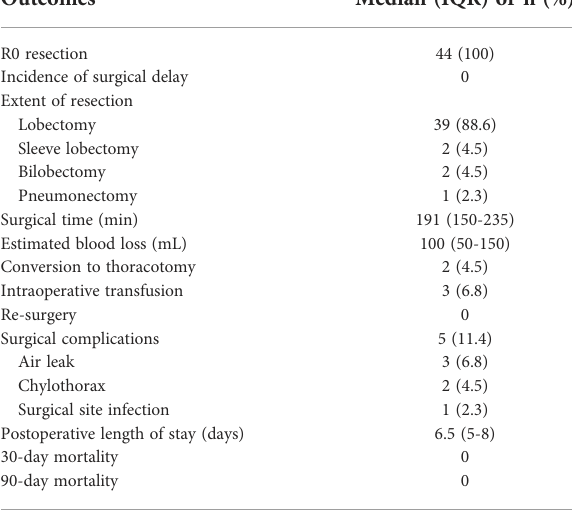
TABLE 3 Surgical outcomes of patients undergoing robotic-assisted resection after neoadjuvant chemoimmunotherapy. Outcomes Median (IQR) or n